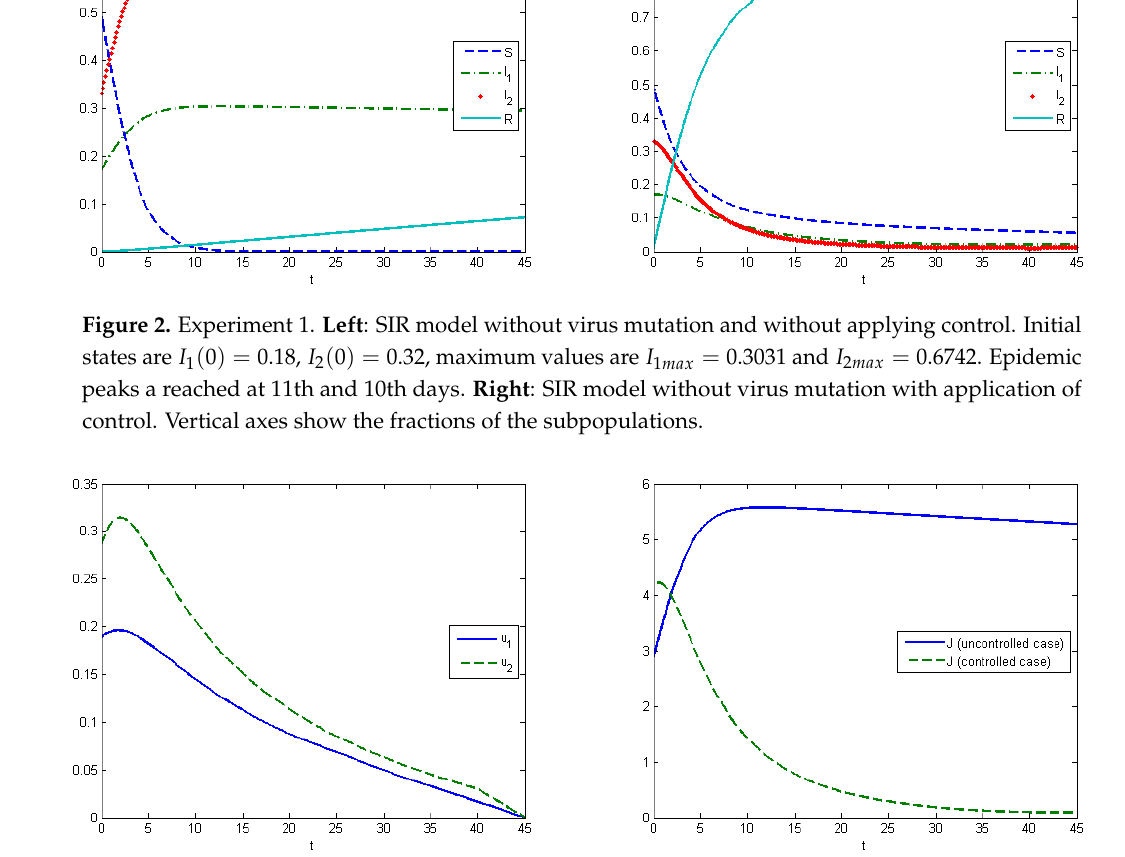
Figure 3. Experiment 1. Left : Optimal control in SIR model without virus mutation; cost functions are convex h i ( u i ) . Vertical axis shows the amount of applied control. Right : Comparison of aggregated costs of SIR model without virus mutation (Controlled model: J = 268.35; uncontrolled model: J = 1004.43). Vertical axis shows the aggregated costs at time moment t in m.u. Experiment 2 represents the SIR model with virus mutation. Infection rates δ i ( t ) , i = 1, 2